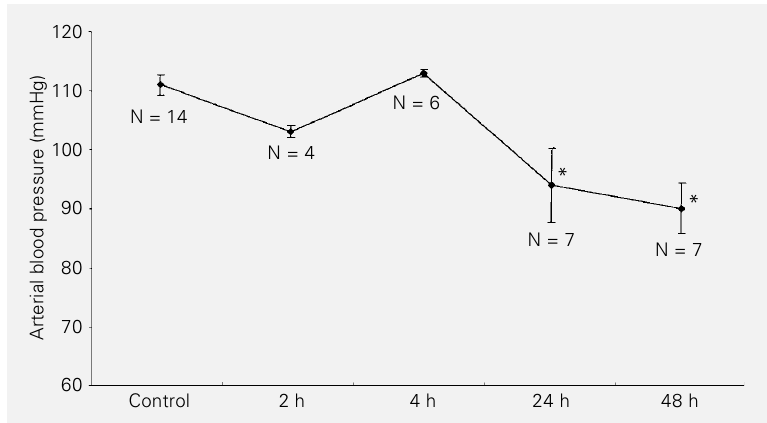
Figure 1 - Arterial blood pressure in acute experimental pancreatitis. Data reported as means – SD for N animals in each group. *P<0.05 compared to control (analysis of